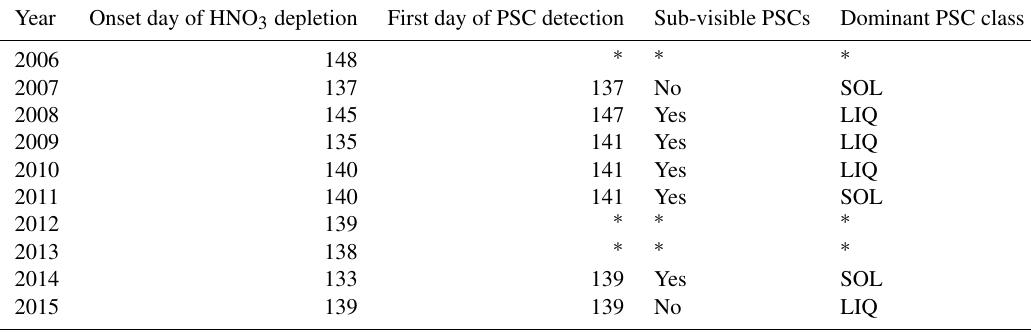
Table 2. Comparison of times of occurrence of HNO 3 depletion and detection of PSCs at the start of each PSC season. Year Onset day of HNO 3 depletion First day of PSC detection Sub-visible PSCs 2006 2007 137 137 No SOL 2008 145 147 Yes LIQ 2009 135 141 Yes LIQ Yes LIQ 140 141 Yes SOL 2012 139 2013 138 2014 133 139 Yes SOL 2015